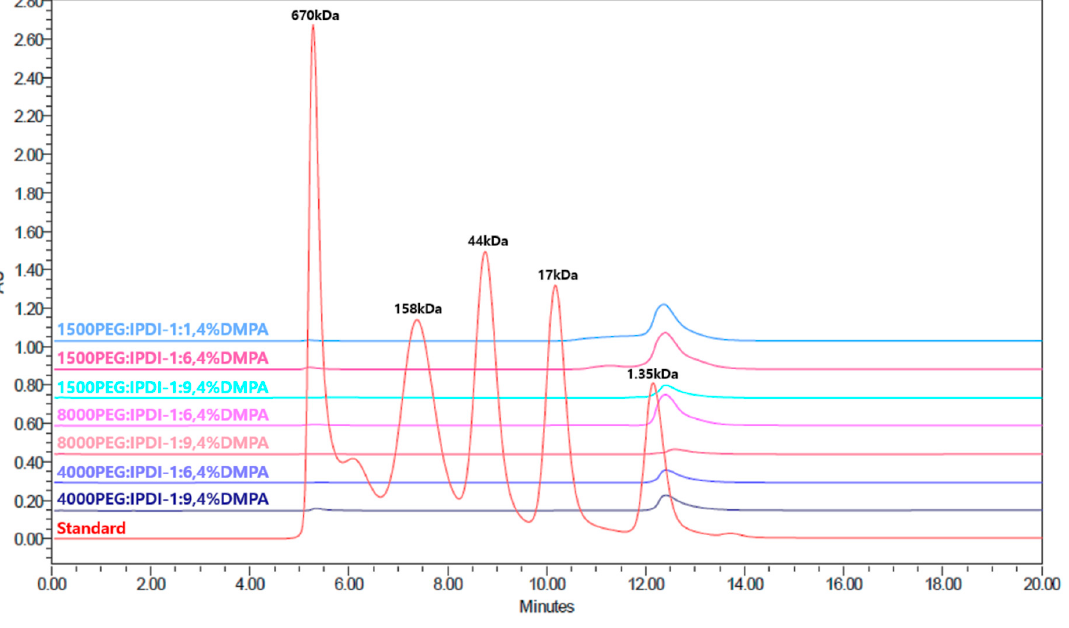
Figure 5. Size-exclusion chromatography (SEC) analysis results of molecular